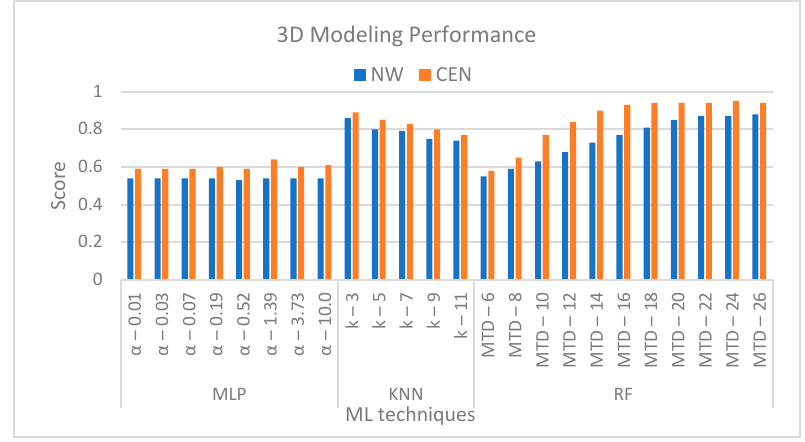
Figure 7. Variation in ML prediction performance in both NW and CEN. Table 12. Confusion matrix for 3D RF modeling for NW.